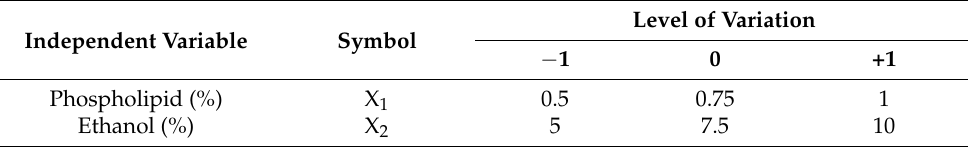
Table 6. Independent variables, level of variation and the dependent variables. Independent